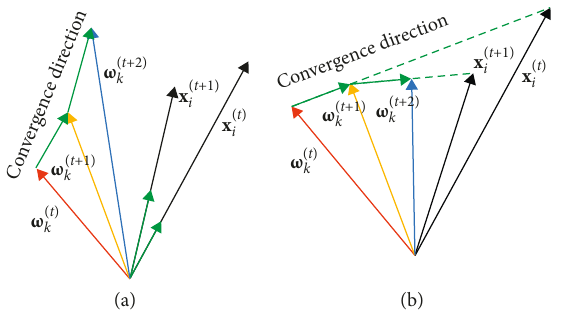
Figure 2: Illustration of convergence direction change in the cases of (a) inner product metric and (b) Euclidean distance